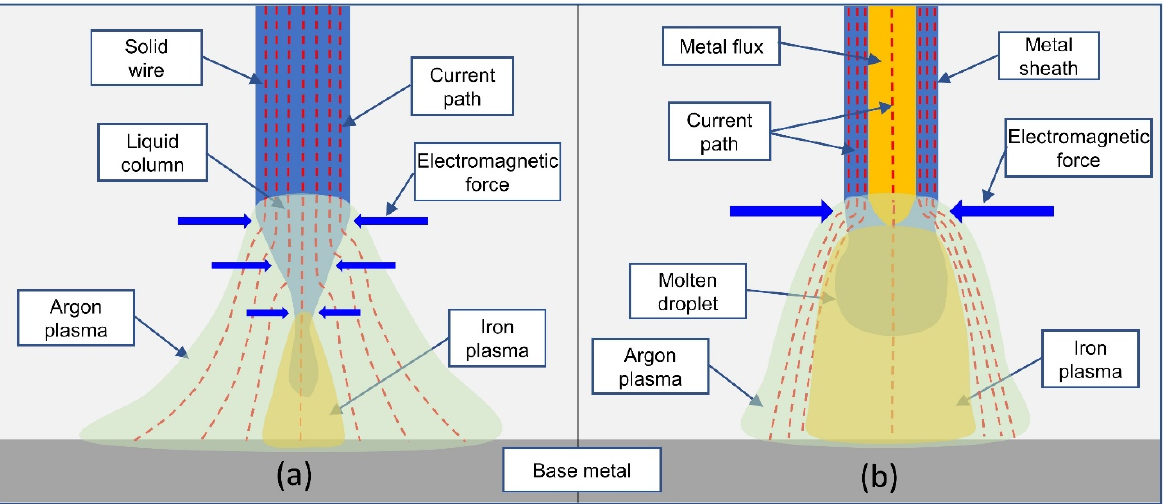
Figure 8. Mechanism of streaming transfer mode in solid wire ( a ) and globular transfer mode in metal ‐ cored wire ( b ).